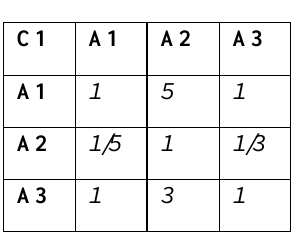
Table 4.3 Matrix M2: comparison of alternatives by the ratio of preference with respect to the criterion 1